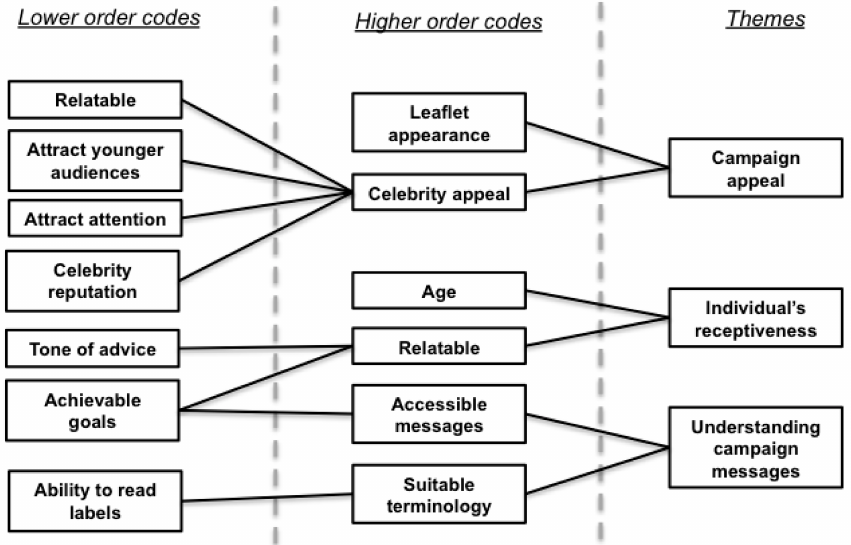
Figure 4. Hierarchical model of themes relating to Sugar Smart reception.